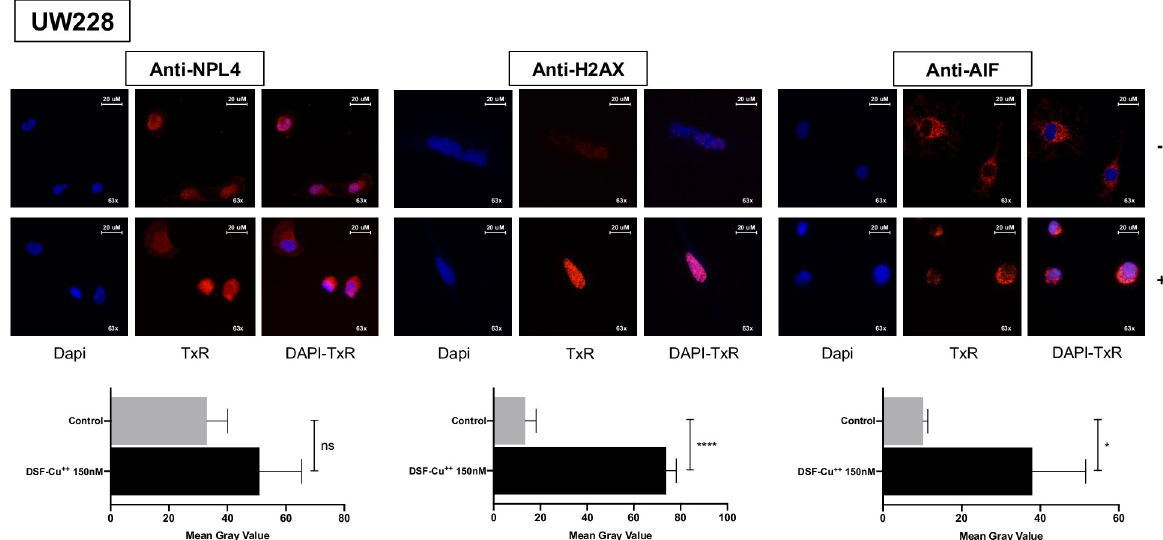
Fig 4. DSF-Cu ++ induces nuclear translocation of AIF, and clustering of H2AX and NPL4. A) Higher NPL-4 clustering in the cell cytoplasm and nucleus was noticed after treatment with DSF-Cu ++ , compared to control. B) nuclear foci of H2AX appear in the nuclei of cells treated for 24h with 150nM DSF-Cu ++ . C) UW228 cells showed nuclear translocation of AIF, a marker of apoptosis, after DSF-Cu ++ treatment. Alternatively, this marker accumulates in the cytoplasm in control cells. Images were acquired at 63x magnification. Legend;—control, + 150 nM for